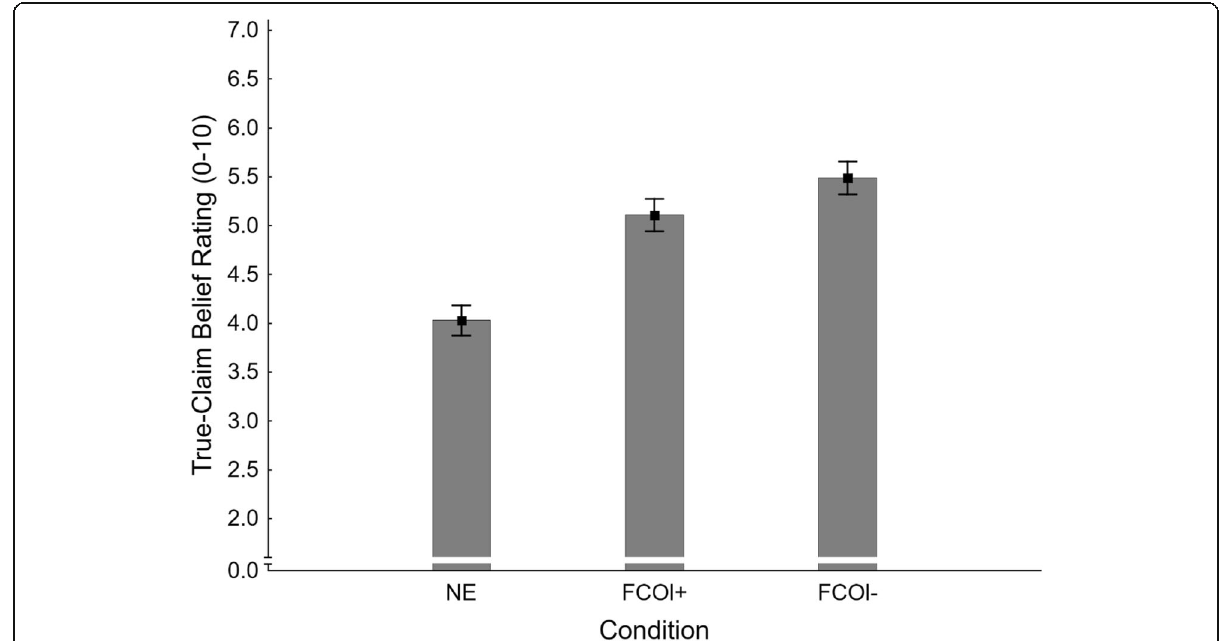
Fig. 15 Mean true-claim belief ratings across conditions NE (no-exposure) and FCOl± (fact-check-only, with/without cognitive load) in Experiment 3. Error bars show standard errors of the